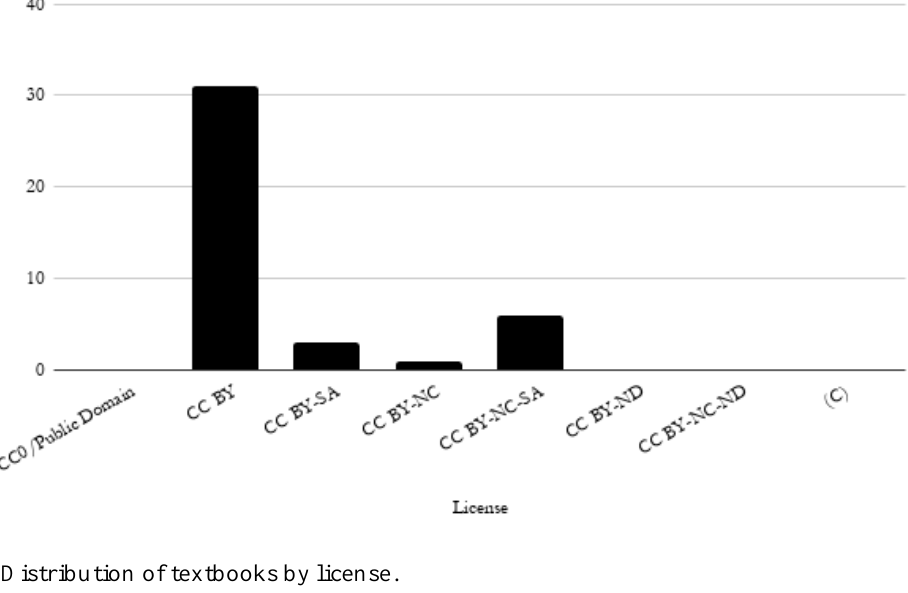
Figure 3 . Distribution of textbooks by